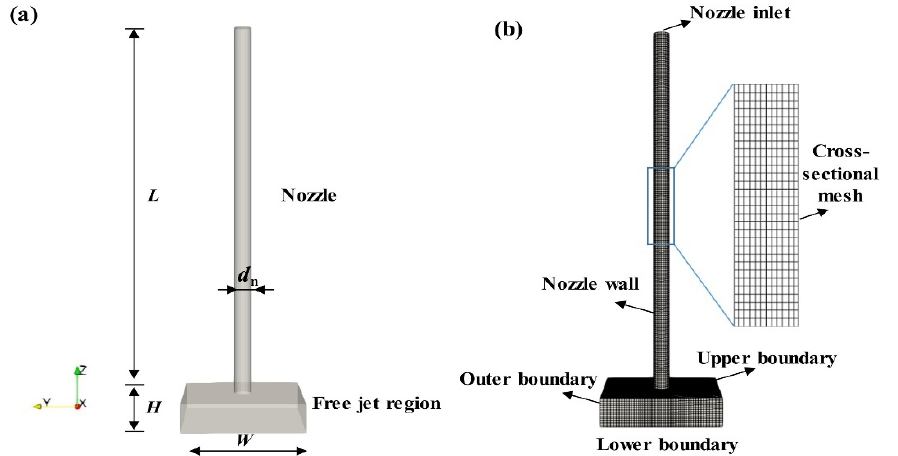
Figure 20. The geometry and boundaries of the computational domain and the numerical meshes: ( a ) Schematic diagram of the computational domain, ( b ) the mesh distribution and boundary settings for the AAJ simulation [133].